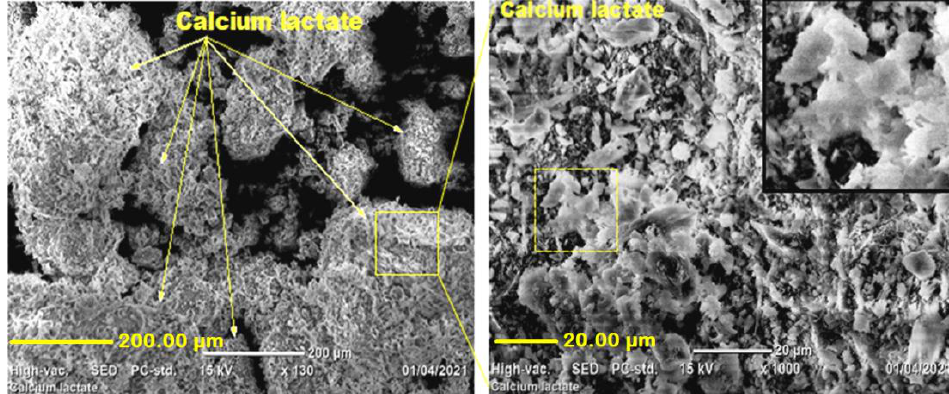
Figure 4. SEM images of the synthesized calcium lactate powder.